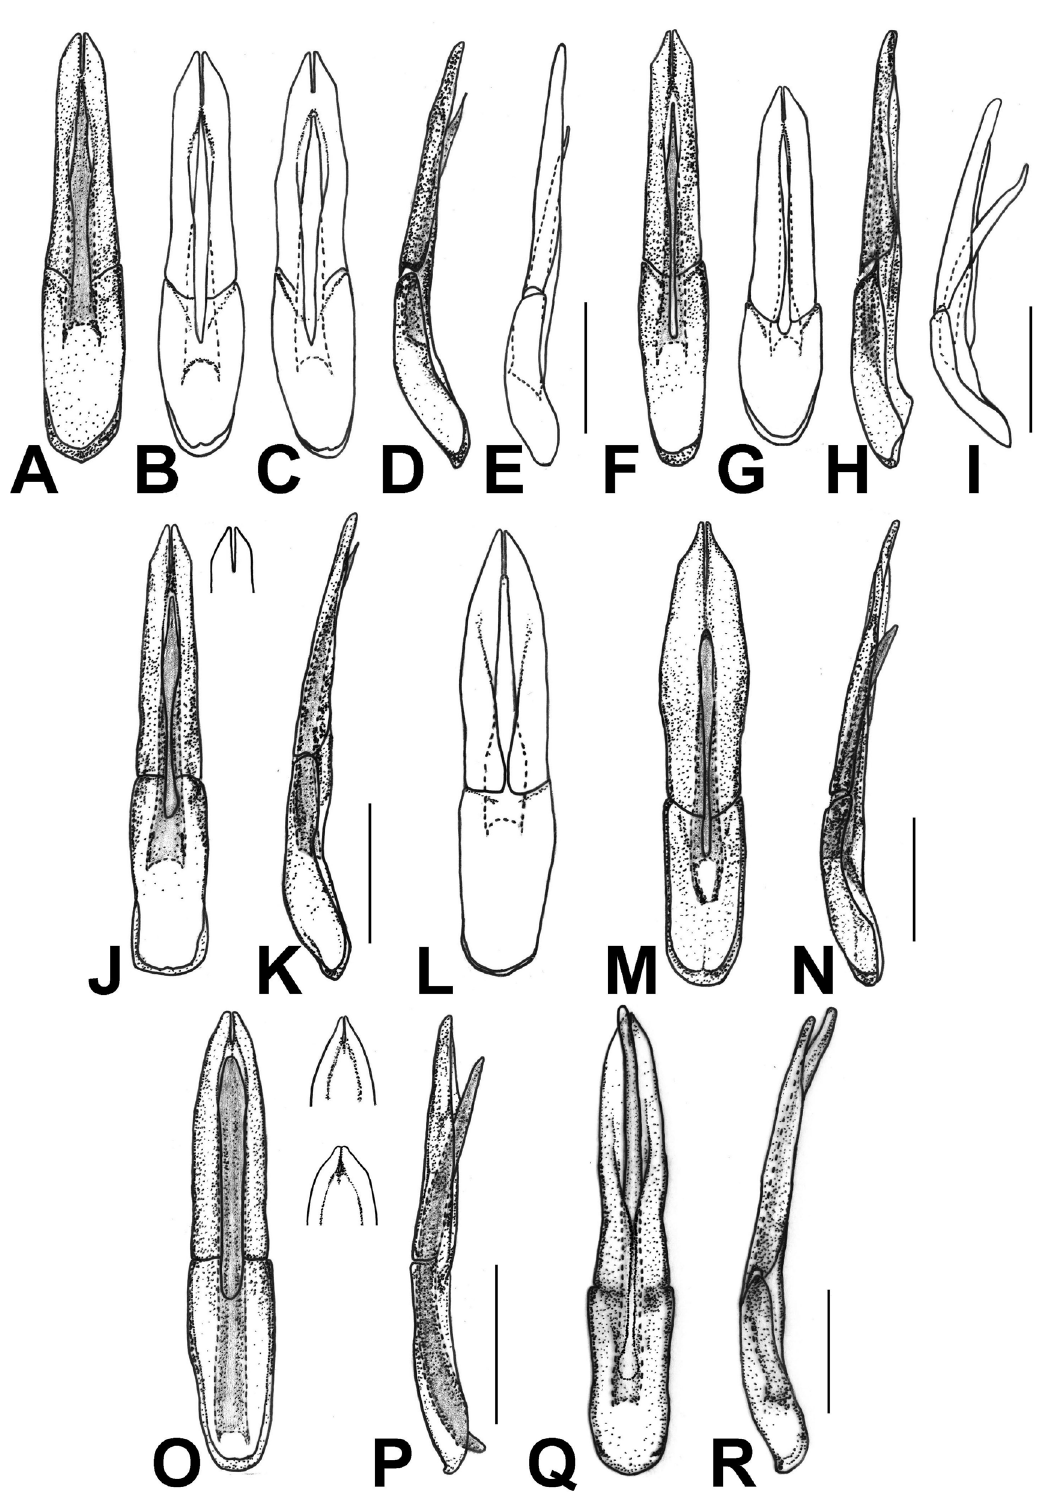
Fig. 6. Aedeagus. A–E . Synchroa punctata Newman, 1838. F–I . S. melanotoides Lewis, 1895. J–K . S. chinensis Nikitsky, 1999. L . S. formosana Hsiao, 2015. M–N . S. elongatula Nikitsky, 1999. O–P . Synchroina tenuipennis Fairmaire, 1898. Q–R . Thescelosynchroa pangu (Hsiao, Li, Liu & Pang, 2016) gen. et comb. nov. — A–C , F–G , J , L–M , O , Q . Dorsal view. D–E , H–I , K , N , P , R . Lateral view. Scale bars: 0.5